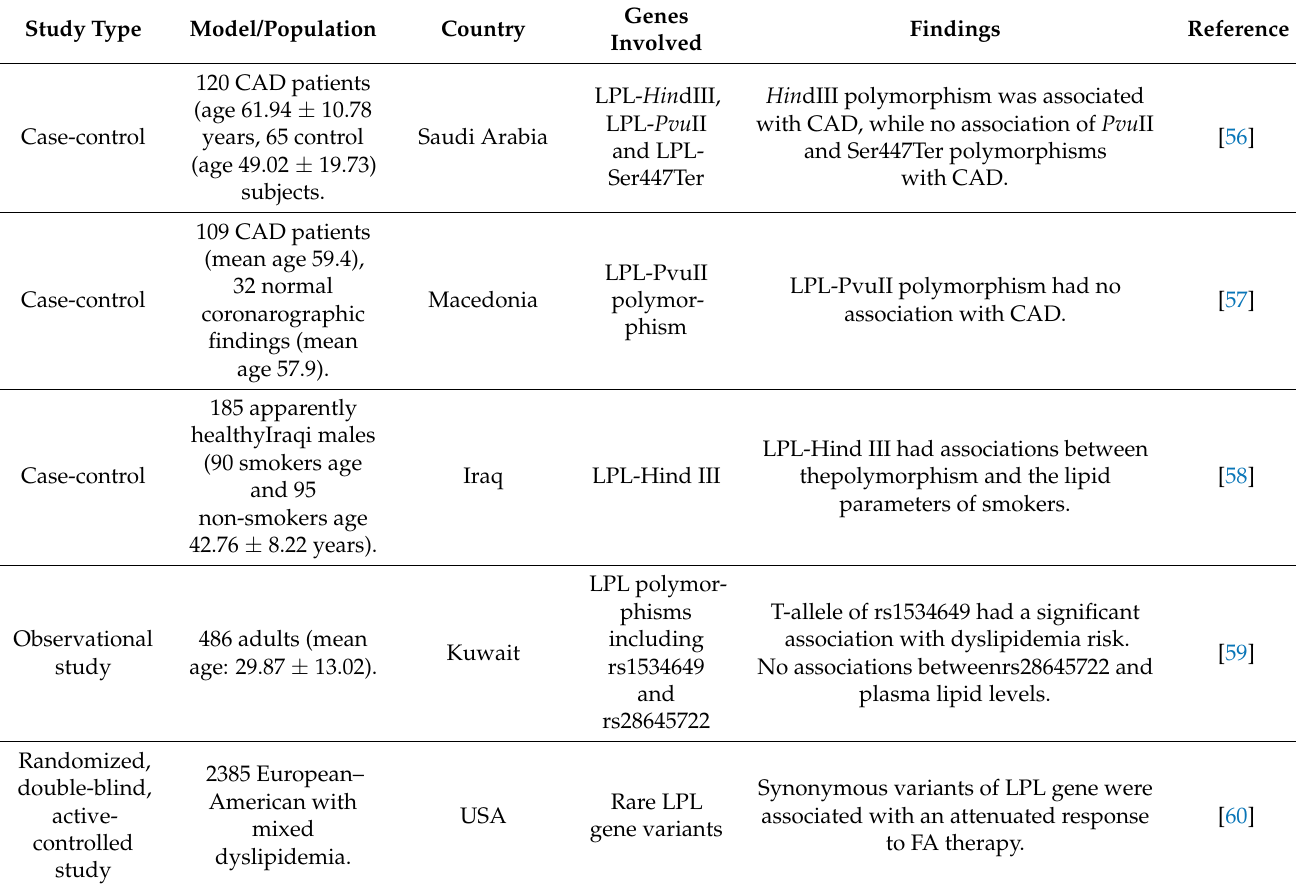
Table 2. The relationship between specific polymorphisms of lipoprotein lipase and lipid